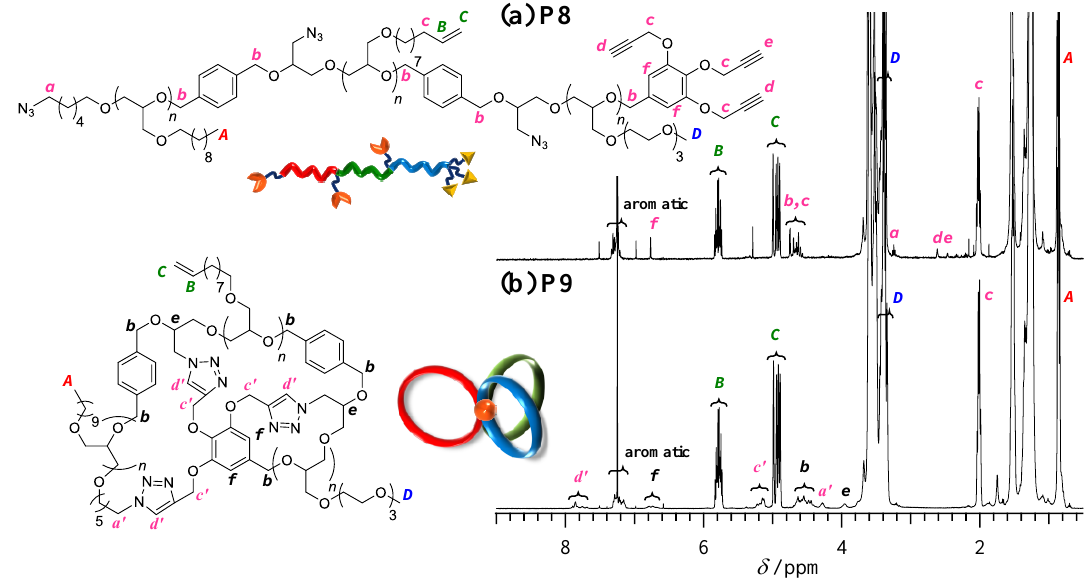
Figure 5. ( a , b ) 1 H NMR spectra of P8 and P9 in CDCl 3 (400 MHz).